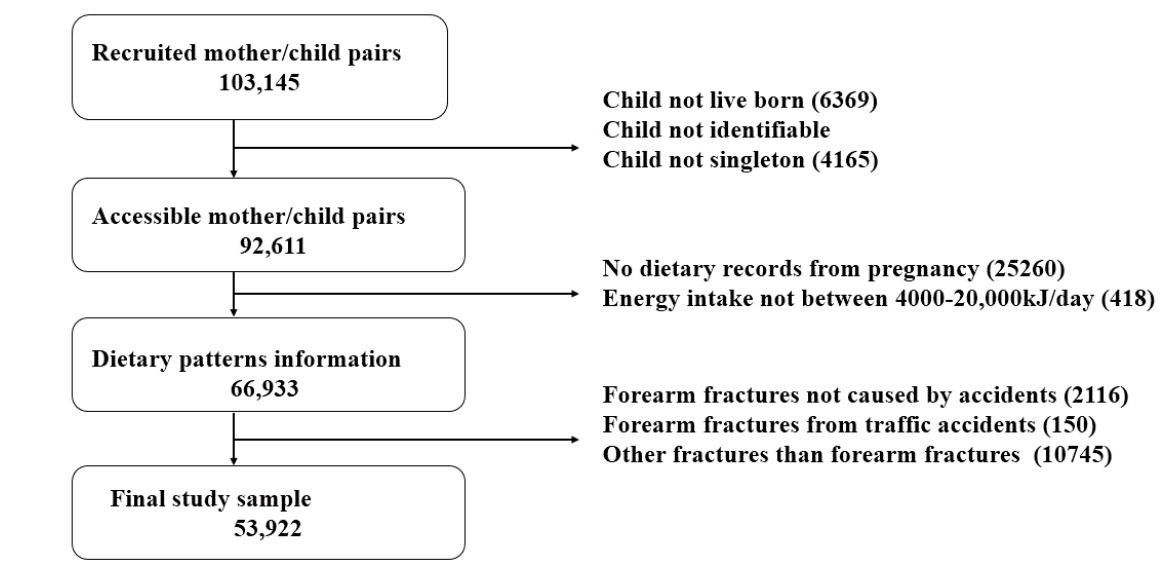
Figure 1. Flow chart of the steps in the derivation of the final study